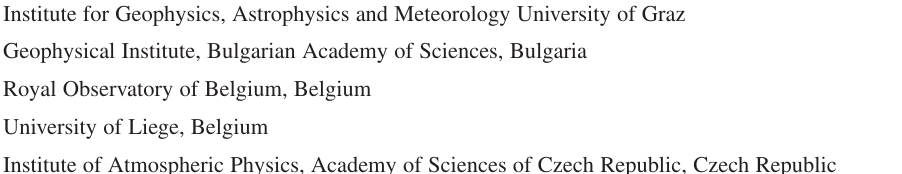
Table III. Participating institutions from COST